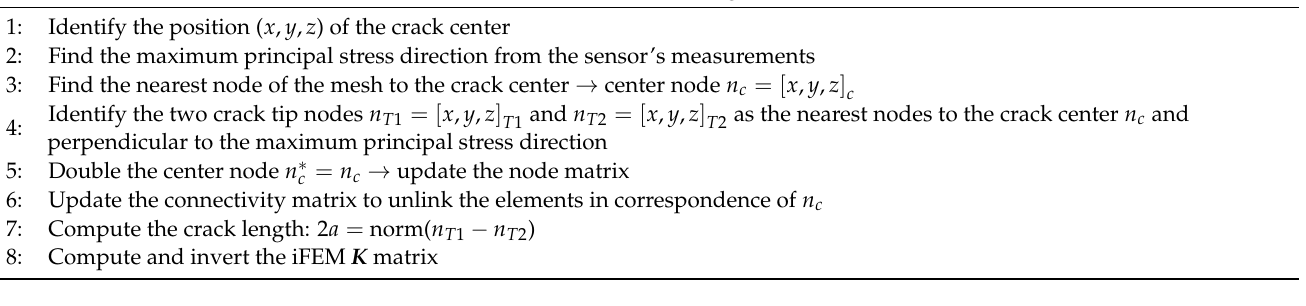
Algorithm 2: Crack propagation from an existing damage condition